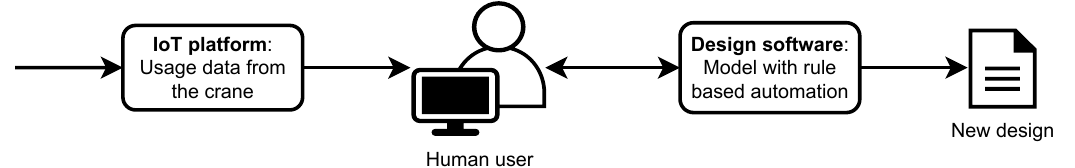
Figure 10. The data flow of the design automation case. The usage data originally comes from the crane as described in Case 1 (Section